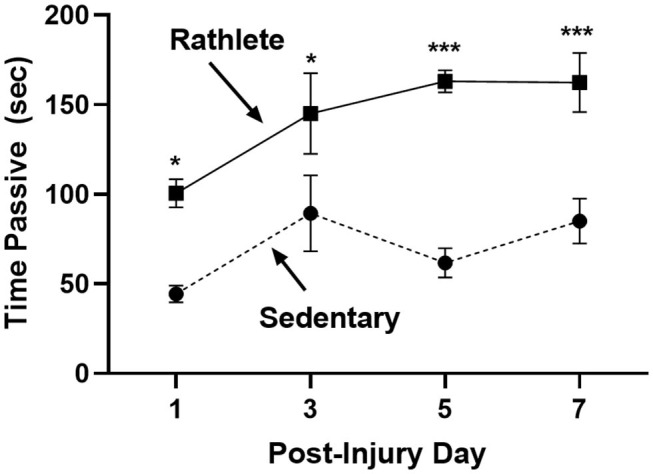
Open field test for anxiety: Rathlete shams (solid line) were compared to sedentary shams (dashed line) for performance in an open field task. Following repeat sham procedure, rats were tested for time spent immobile over the 5 min of the task. Rathlete shams showed more time in passive (immobile) time. *p < 0.05, ***p < 0.001.